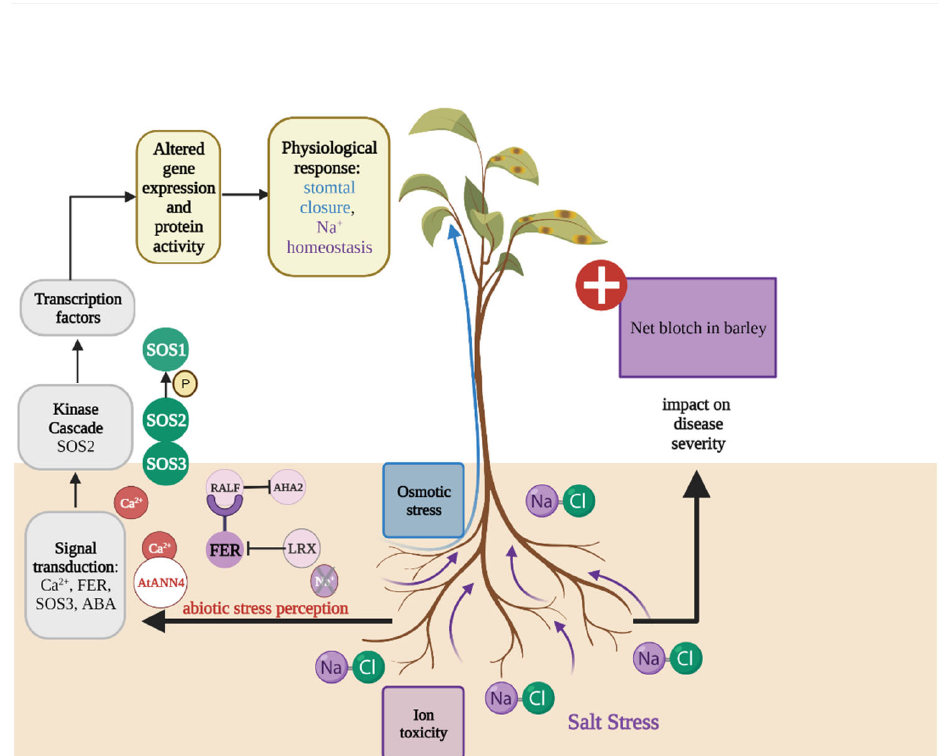
Figure 3. Overview of the salt stress signalling pathway in plants and effects of host salt stress on Dothideomycete-induced disease severity. Figure 3 highlights two pathways that are involved in the salt response leading to sodium (Na + ) homeostasis ( left ) and the effect of salt stress on Dothideomycete-induced disease severity ( right ). In A. thaliana , the malectin receptor-like kinase FERONIA (FER)-pathway involves specific binding of rapid alkalisation factors (RALFs), which leads to FER phosphorylation and inhibition of plasma membrane H + -ATPase 2 (AHA2) and results in cell wall alkalisation. Salt stress-associated cell wall damage is sensed by the FER signalling pathway (purple) and is proposed to trigger transient cytosolic calcium ion (Ca 2+ ) accumulation. In the absence of salt stress, leucine-rich-repeat extensins (LRXs) interact with RALFs and prevent the interaction with FER. The salt overly sensitive (SOS) pathway (green), which comprises a Ca 2+ -binding protein SOS3, leads to the export of Na + from root epidermal cells to the soil via the Na + /H + antiporter SOS1. SOS3 activates SOS2, a protein in the sucrose nonfermenting 1 (SNF1) related protein kinase 3 (SnRK3) family. At the plasma membrane, the SOS3 ‐ SOS2 complex phosphorylates SOS1 resulting in increased Na + efflux. The Ca 2+ permeable transporter AtANN4 in A. thaliana may form a negative feedback loop to fine tune the influx of Ca 2+ in response to salt stress.